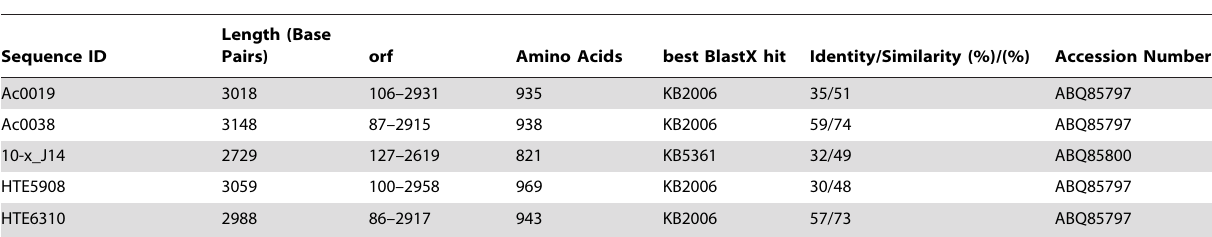
Table 1. Sequence properties of the ketoacyl snthases transcripts identified in A. ostenfeldii and H. triquetra.